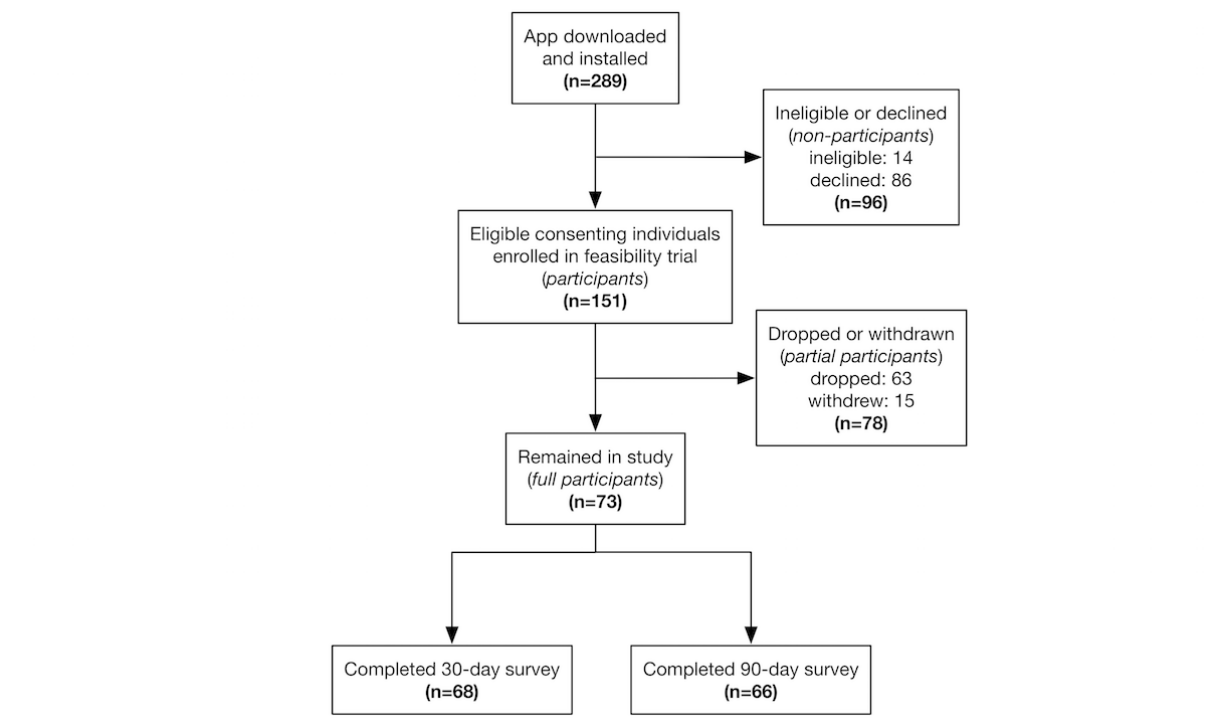
Figure 2. Flow of participants through the See Me Smoke-Free (SMSF) feasibility trial.